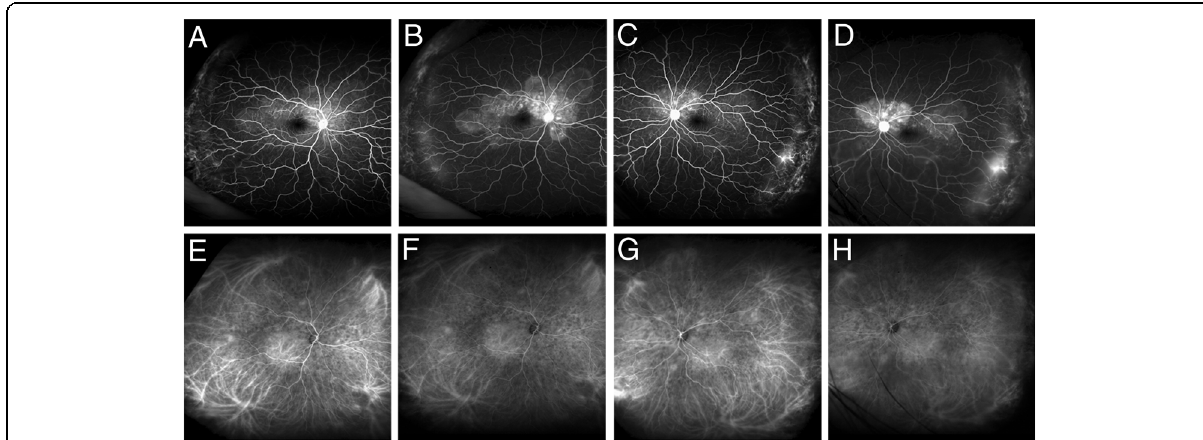
Fig. 2 Baseline wide-field angiography findings using Optos California. a – d Fluorescein angiograms. a Early phase image in the right eye. b Late phase image in the right eye. c Early phase image in the left eye. d Late phase image in the left eye. Hyperfluorescence indicating pooling due to multiple serous retinal detachments in the posterior lesions and hyperfluorescence due to leakage in the temporal periphery were observed in both eyes. e – h Indocyanine green angiograms. e Early phase image in the right eye. f Late phase image in the right eye. g Early phase in the left